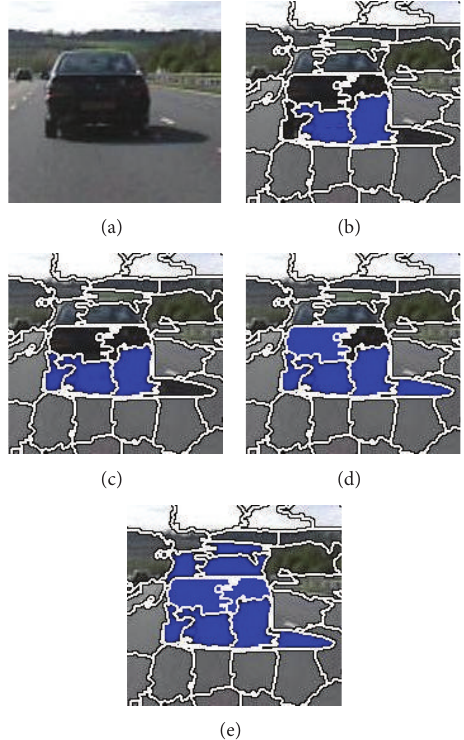
Algorithm 1 (Clustering Method for Vehicle Candidate Gen-